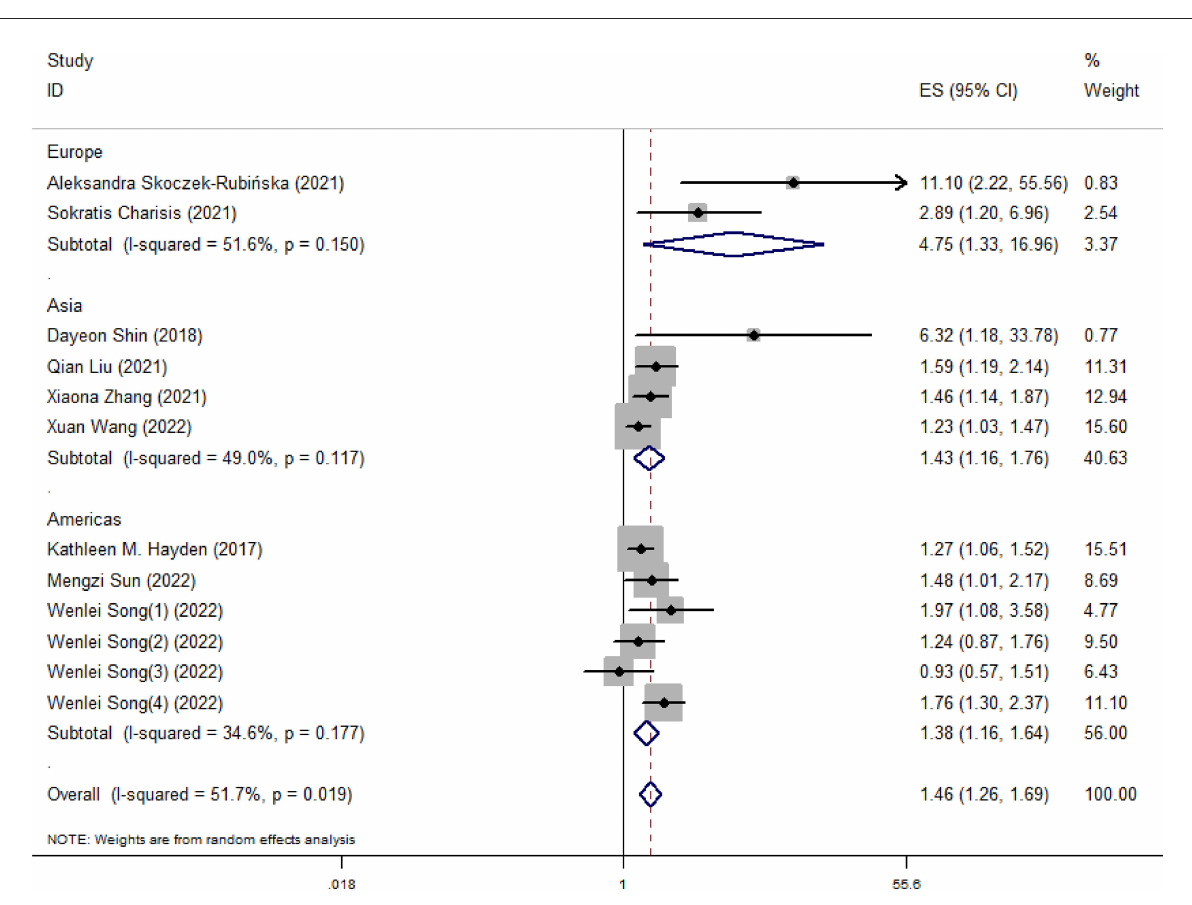
FIGURE4 Meta-analysis results of higher DII for the risk of cognitive impairment (subtotals on the basis of study